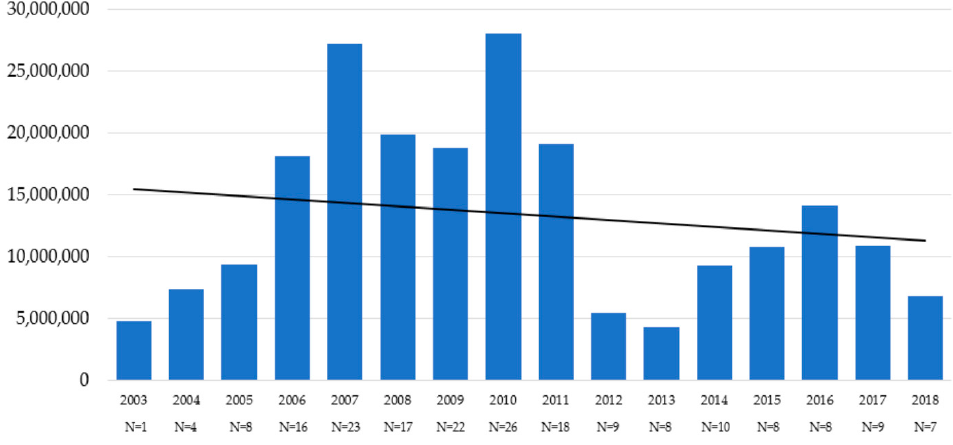
Figure 2. Total funding in USD of R/S projects by